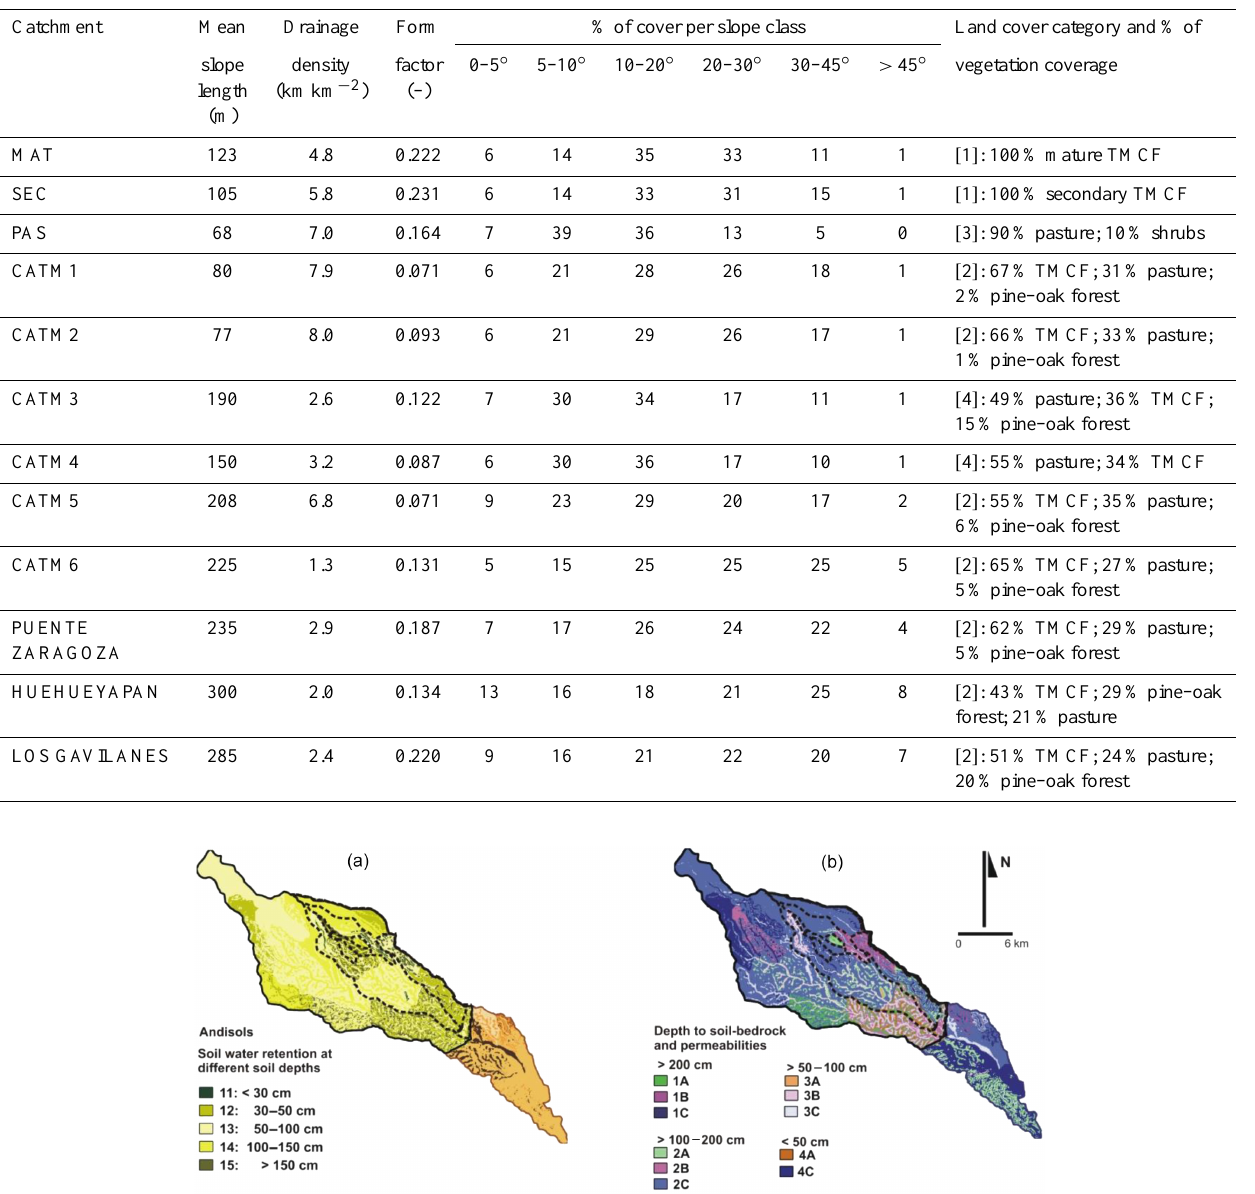
Figure 4. Map of hydro-pedologic properties of the Los Gavilanes river catchment. (a) Soil water retention at field capacity in the solum. Category 11: < 180mm; category 12: ≥ 180 ≤ 310mm; category 13: ≥ 310 ≤ 580mm; category 14: ≥ 580 ≤ 850mm; and category 15: ≥ 850mm; and (b) depth to soil–bedrock interface and corresponding saturated hydraulic conductivities ( K s ). For depth < 100cm, K s cate- gories A, B, and C correspond to K s > 36; 14 <K s ≤ 36 and 1 <K s ≤ 14mmh − 1 , respectively. For depth > 100cm, A, B, and C correspond to K s > 144; 36 <K s ≤ 144 and 4 <K s ≤ 36mmh − 1 ,